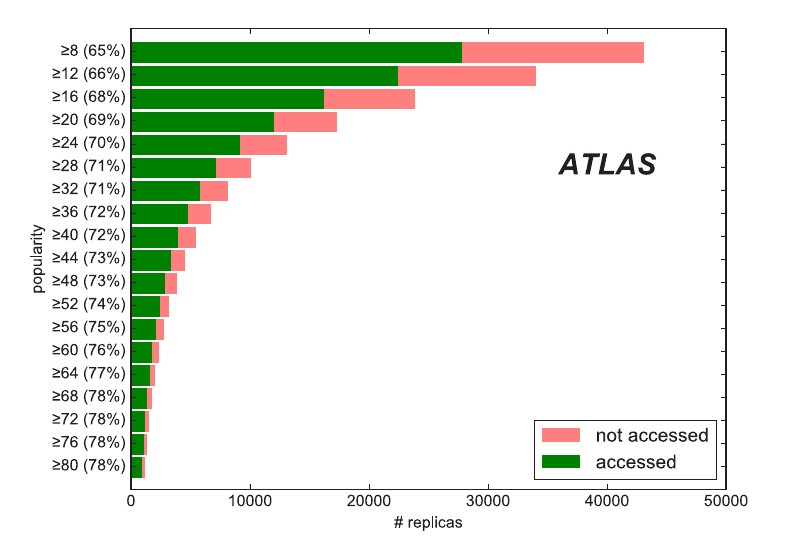
Figure 2. Number of accessed and not accessed replicas that pass selection on lower thresholds on the popularity of their associated datasets seven days before the replica